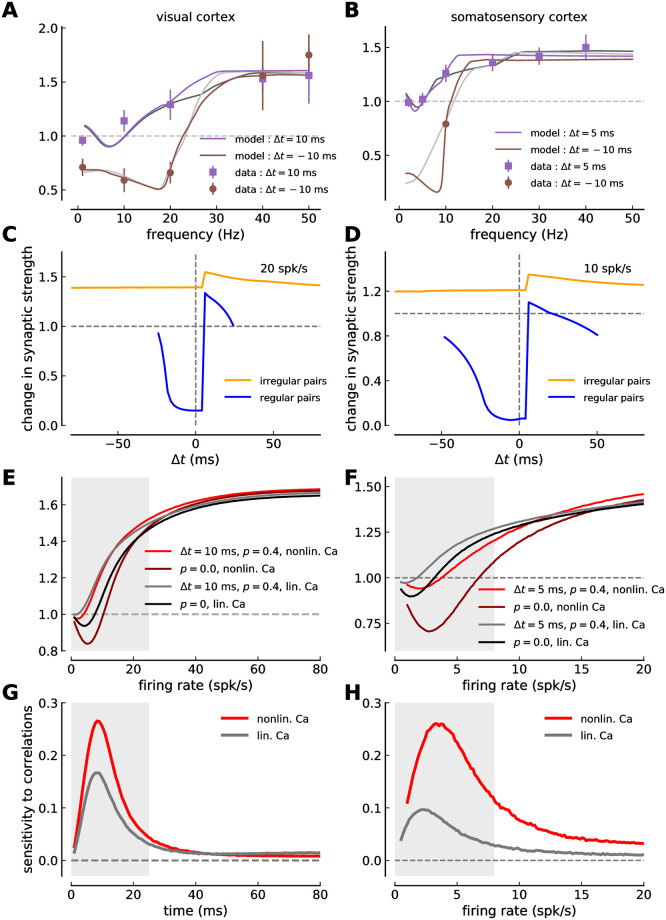
Comparison of synaptic changes in linear- and nonlinear calcium dynamics model versions.(A, B) Model fit (solid lines) to the experimental plasticity data obtained in visual cortex (A, mean ± SEM, [2]) and somatosensory cortex (B, mean ± SEM, [3]). Same depiction as in Fig 2. The purple and brown lines show the model with nonlinear calcium dynamics fitted to the data, while the gray lines are a reproduction from Fig 2A amd 2B of the model with linear calcium dynamics (see Materials and methods). Both model variants implement STD. (C, D) Change in synaptic strength as a function of the time lag between pre- and postsynaptic spikes for irregular (orange) and regular spike-pairs (blue) at an intermediate firing rate for the nonlinear calcium model. The STDP curve for the visual cortex parameter-set is shown in C while a somatosensory example is shown in D. (E, F) Change in synaptic strength in response to irregular pre- and post activity as a function of the firing rate for several values of the correlation coefficient p and one time lag Δt in visual- (E) and somatosensory cortex (F). Two cases are shown for the model with nonlinear calcium dynamics: (i) uncorrelated Poisson spike trains (p = 0, dark red) and (ii) pre-post pairs with Δ = 10 ms in E (Δ = 5 ms in F) at p = 0.4 (red). These two cases are also shown for the linear calcium model: (i) uncorrelated Poisson spike trains shown in black, and (ii) pre-post pairs with Δ = 10 ms in E (Δ = 5 ms in F) at p = 0.4 shown in gray. (G, H) Sensitivity of synaptic changes to spike-pair correlations in visual- (G) and somatosensory cortex (H). The change in synaptic strength due to spike-timing correlations is shown as a function of the firing rate for the nonlinear calcium model (red) and for the linear model variant (gray; same line as in Fig 4C and 4D). Prevalent firing rate ranges in visual- (< 25 spk/s; [41]) and somatosensory cortex (< 8 spk/s; [42]) are marked by gray shaded regions in panels E-H. Note the different firing rate ranges shown on the x-axis between the left and the right column of panels E-H. All changes in panels C-H are in response to a stimulation for 10 s.